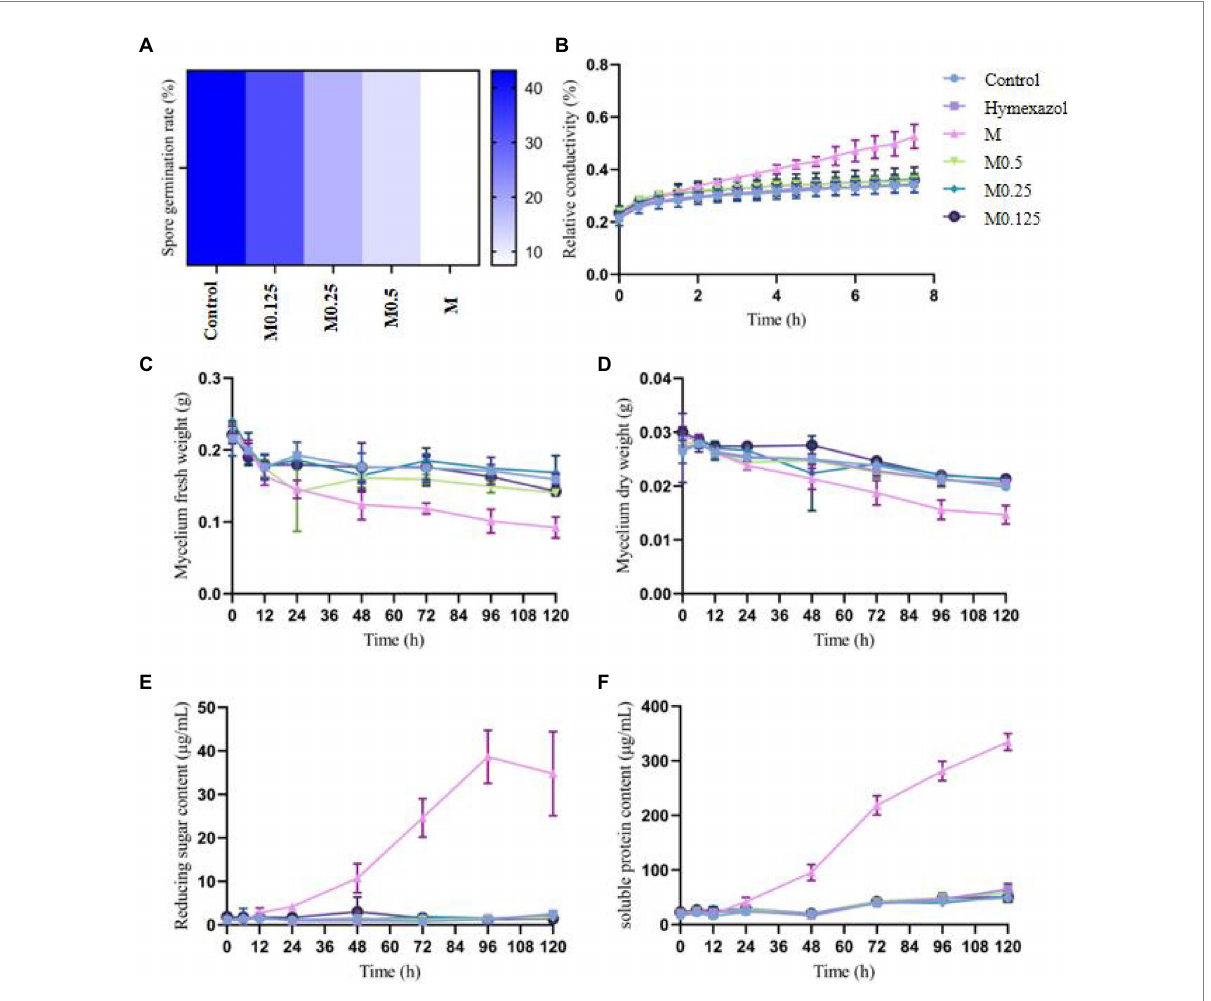
FIGURE 1 Effects of different concentrations of Alpinia officinarum essential oil on the spore germination (A) , cell membrane permeability (B) , fresh weight (C) , dry weight (D) , reducing sugar content (E) and soluble protein content of F. oxysporum (F) . 2-DMSO-T (20/1000 DMSO and 1/1000 Tween-80 suspension) was used as a negative control (CK), and Hymexazol was used as a positive control. The minimum inhibitory concentration (MIC, abbreviation for M) of EO was determined previously to be 1.12 mg/ml. Various A. officinale EO concentration gradients (M, M0.5, M0.25,